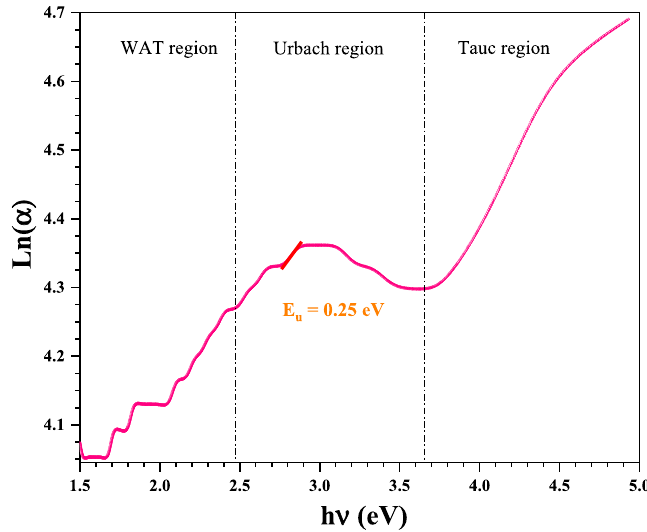
Figure 8. Variations of Ln(α) with incident photon energy of